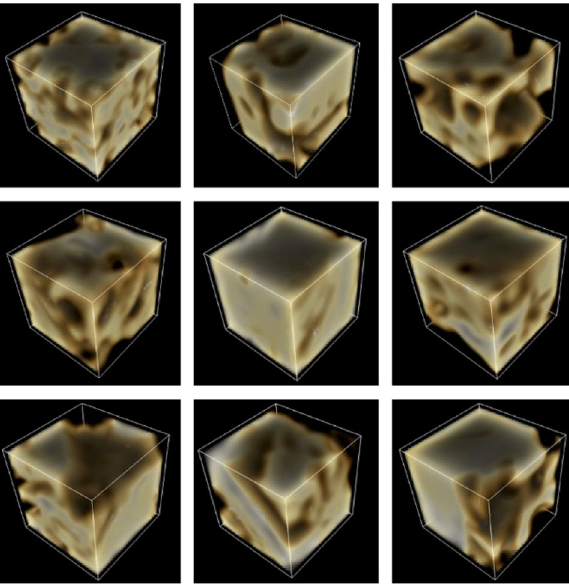
Fig. 12 Examples of class 5 subblocks